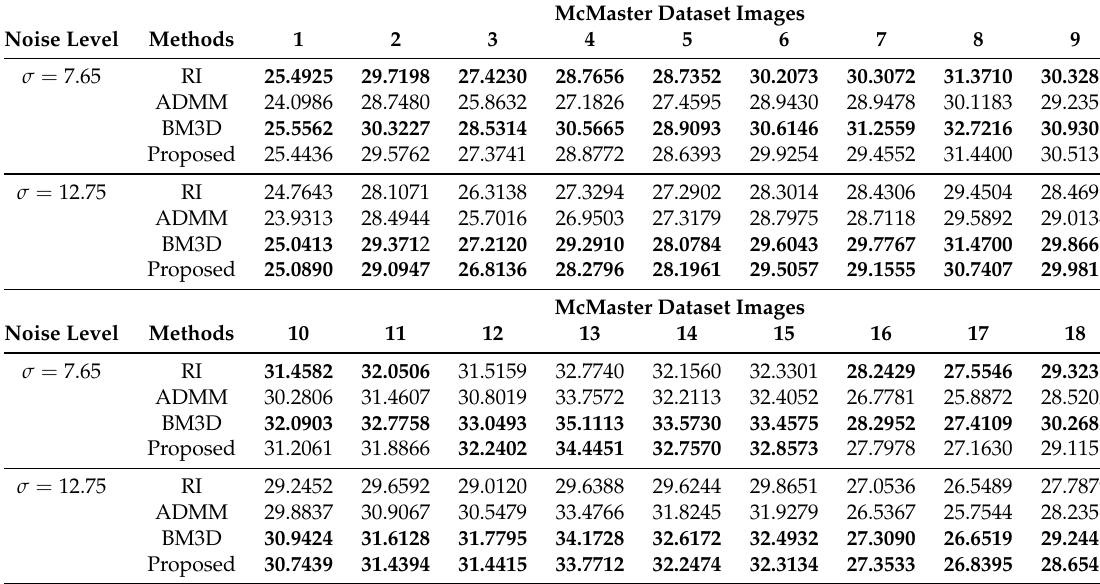
Table 1. Comparison of the PSNR between the different methods. The two best values are in bold font.